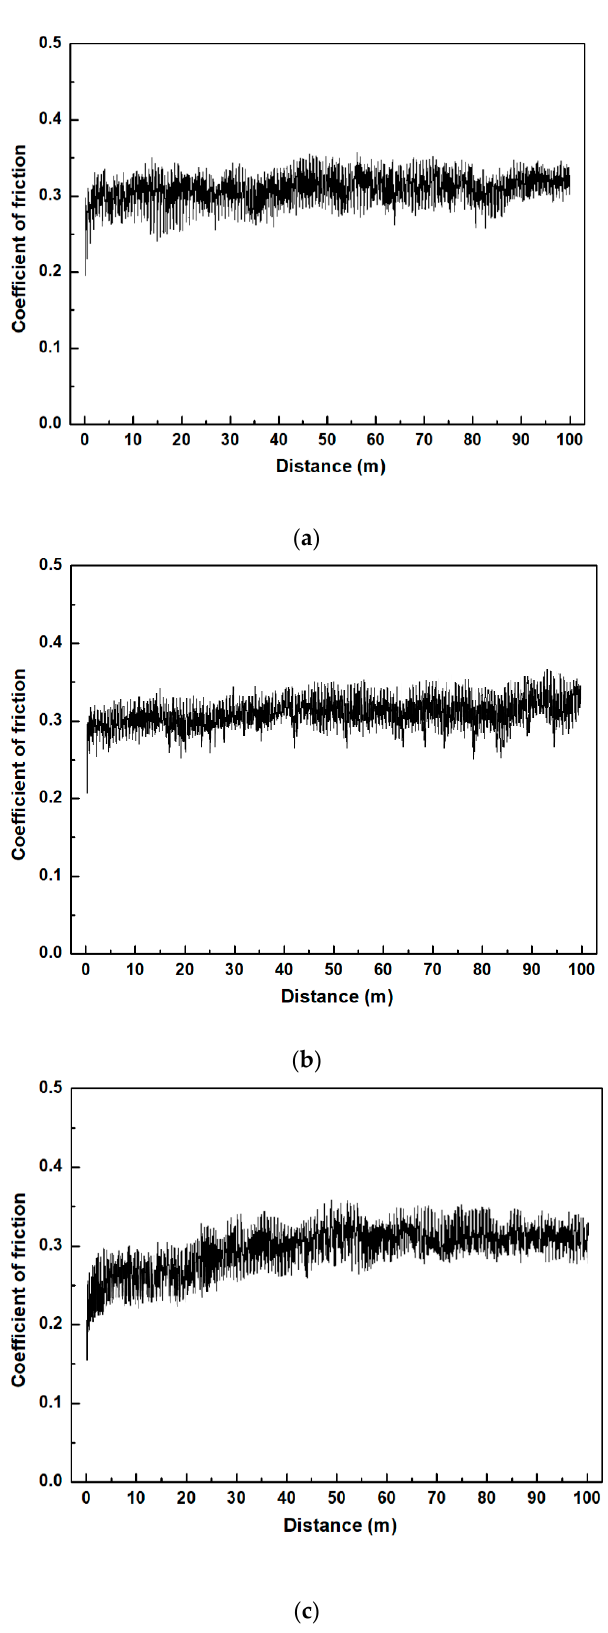
Figure 10. Coefficient of friction obtained from the pin-on-disk test for the ( a ) BM, ( b ) LH P21, and ( c ) LN P21.